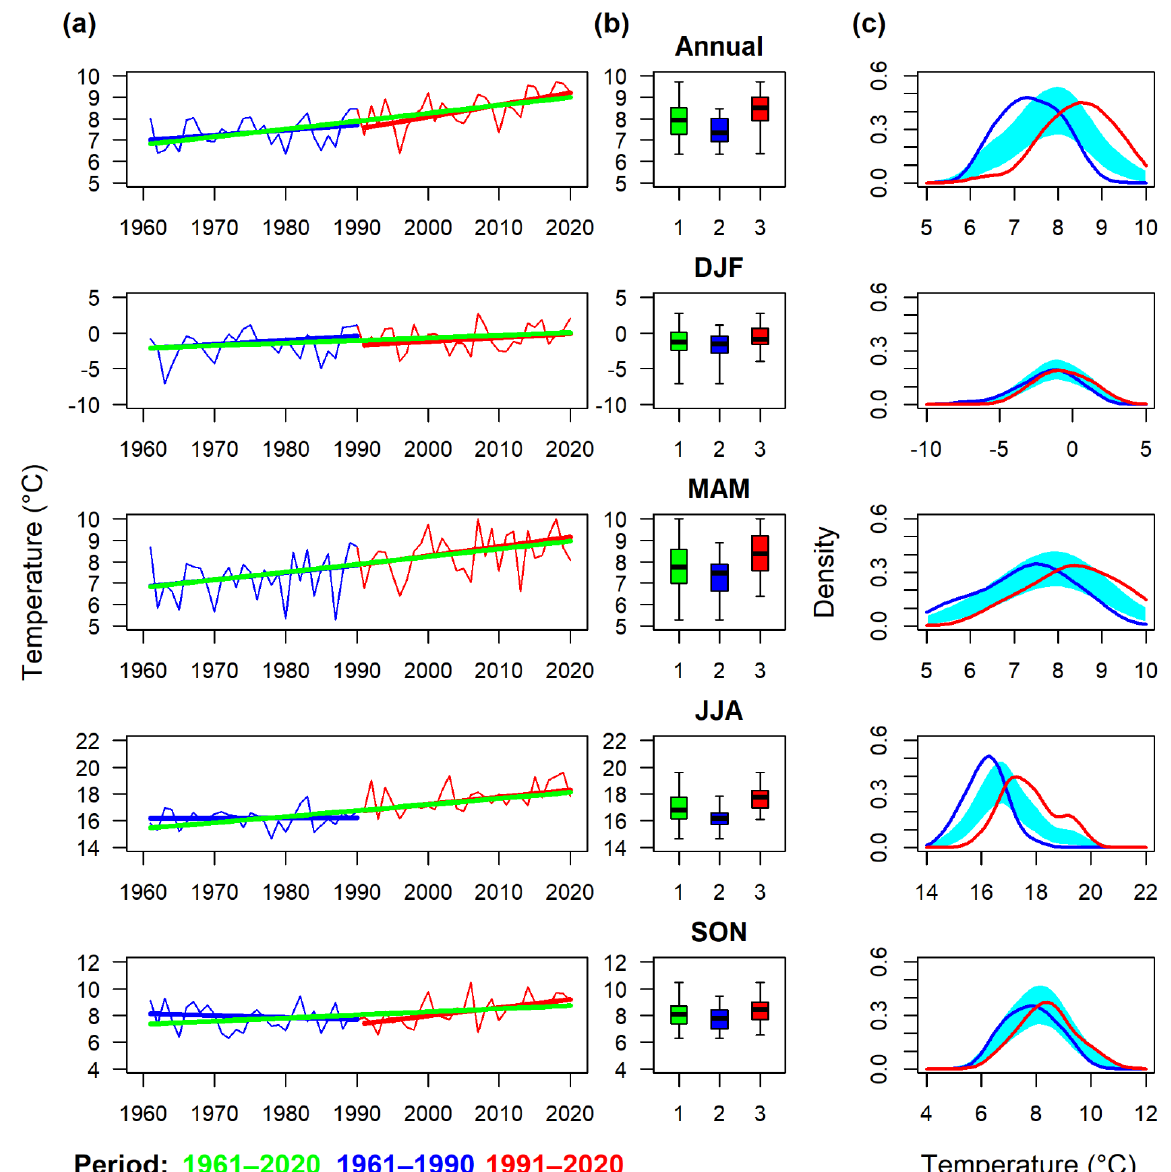
Figure 6. Mean annual and seasonal temperature series for the territory of the Czech Republic in the 1961 – 2020 period: ( a ) fluctuations with linear trends in the entire period, 1961 – 1990 and 1991 – 2020; ( b ) box plots (median, lower and upper quartile, minimum, and maximum) for 1961 – 2020 (1), 1961 – 1990 (2), and 1991 – 2020 (3); ( c ) the density distribution of the series in 1961 – 1990 and 1991 – 2020. The density curves outside the reference band (green – blue) indicate a significant difference in the two distributions (and vice versa).